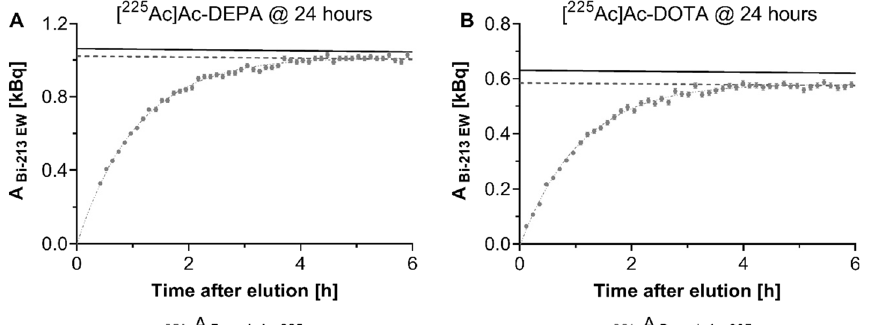
Fig. 7 Multiple time‑point GC measurements were performed of the upper part of iTLC strip using EW 213 before SEq was reached between 213 Bi and 225 Ac (< 5 h), to determine the amount of bound 213 Bi after 24 h of incubation in human serum of [ 225 Ac]Ac‑DEPA ( A ) and [ 225 Ac]Ac‑DOTA ( B ). The solid line represents the total amount of 225 Ac (from GC of both parts of the iTLC strips) and the dotted line the amount of bound 225 Ac. Error bars represent the standard deviation provided by the GC